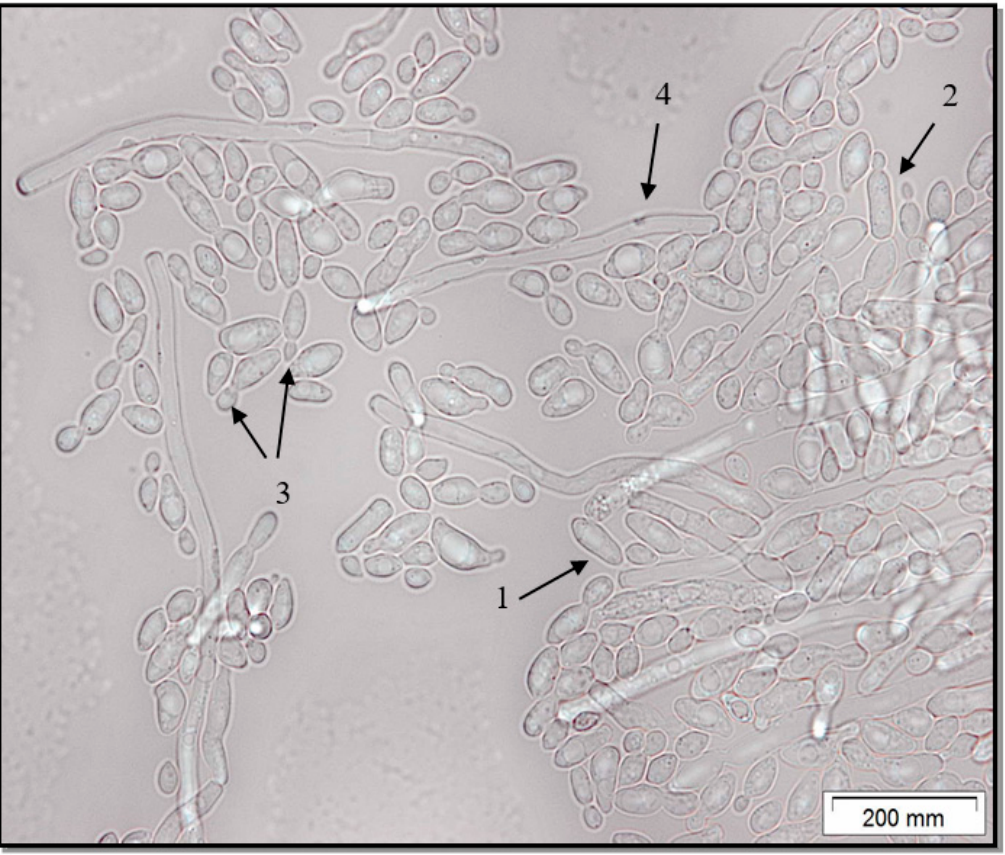
Figure 2. Microscopic structures of C. parapsilosis such as the yeast form are oval ( 1 ) and cylindrical ( 2 ); budding stage ( 3 ); pseudohyphae ( 4 ).